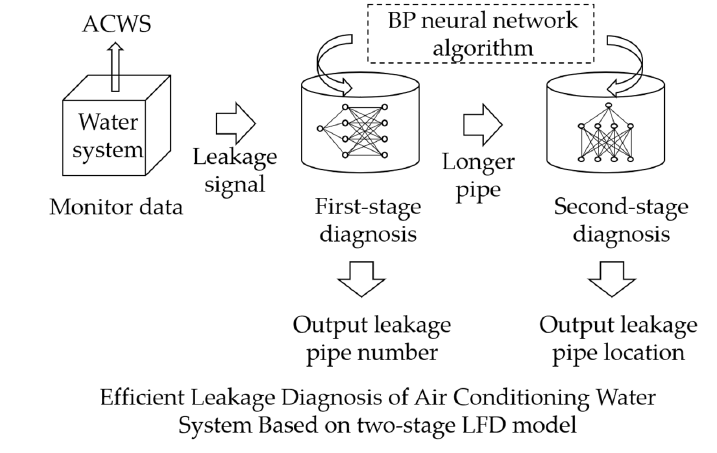
Figure 2. Research path and design